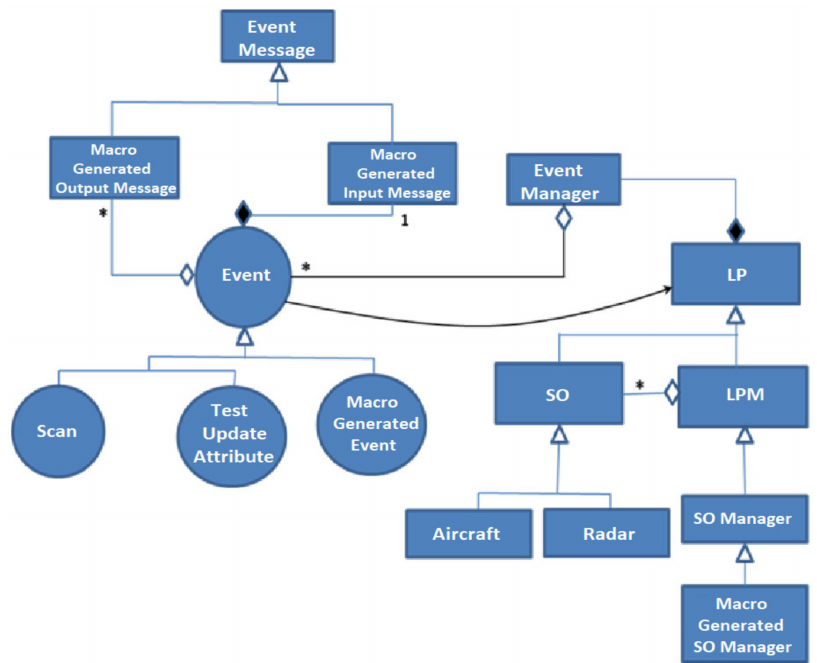
Figure 8. Unified modeling language (UML) schematics of the development with two types of simulation objects ( Aircraft and Radar ) and two events (i.e., Scan and TestUpdateAttribute ). (The symbol * means: